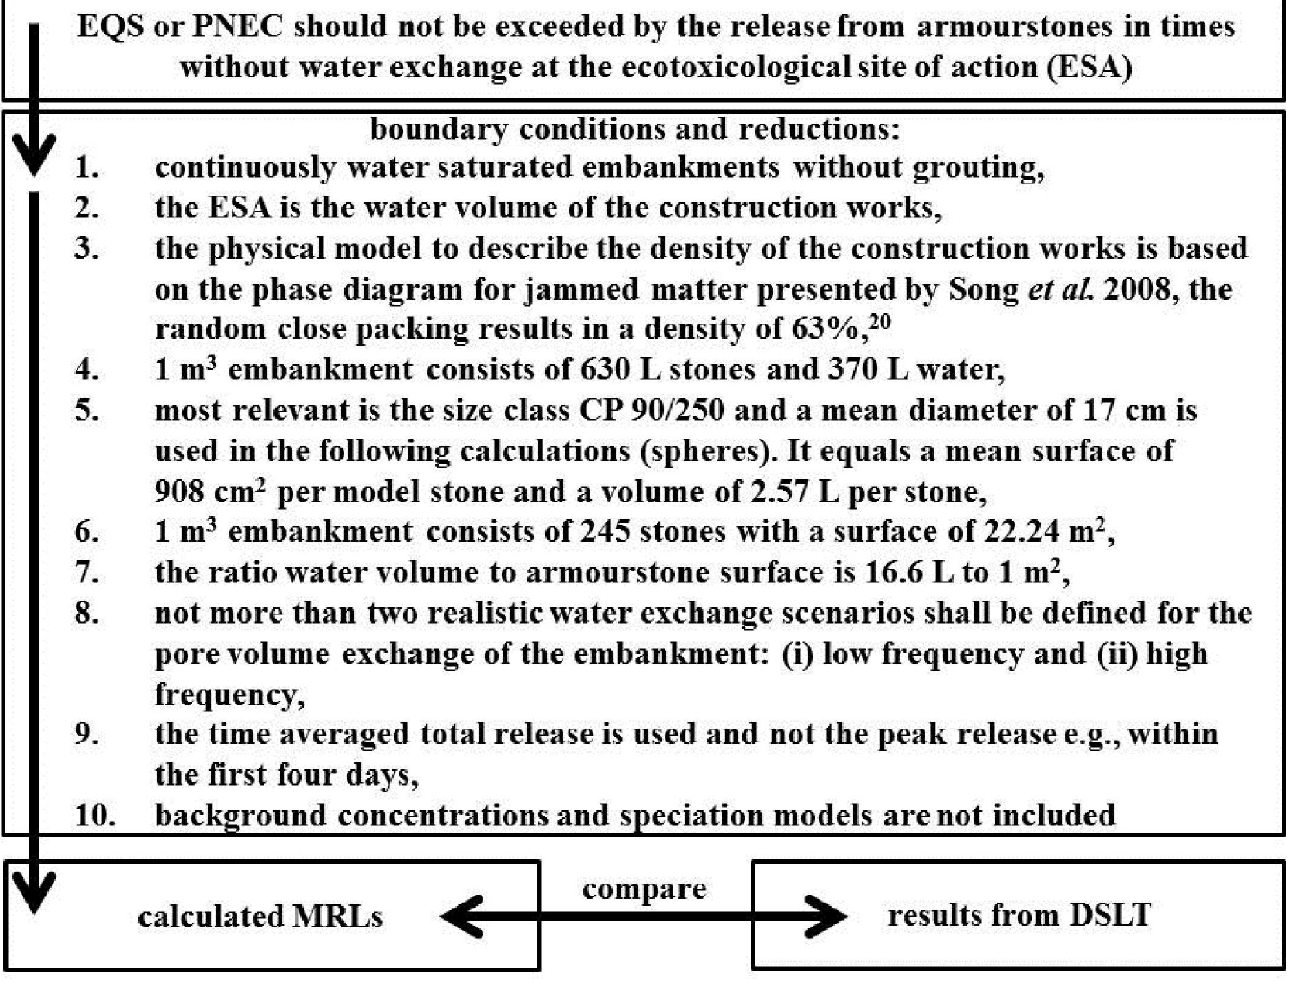
Fig 1. Overview on the model developed to connect environmental target values and results from